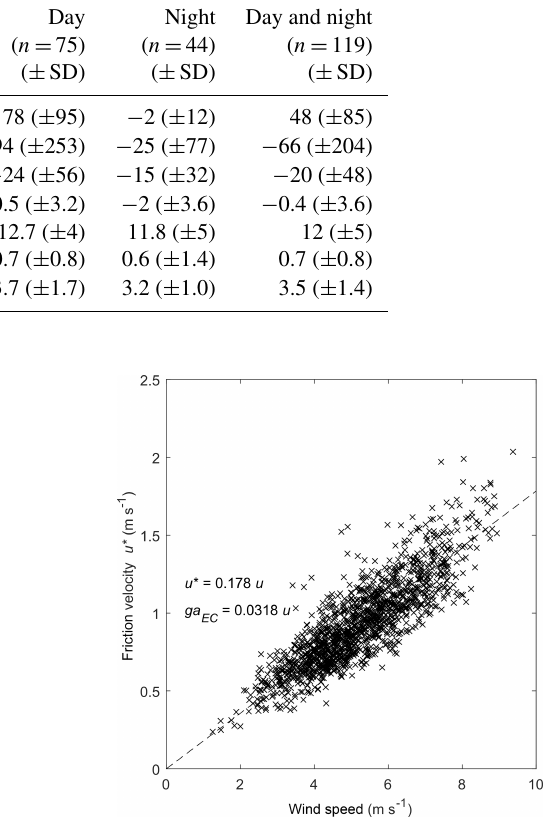
Figure 5. Linear regression of friction velocity u ∗ against wind speed u for near-neutral hours ( − 0.02 <(z − d)/L< 0.02) and from a south-westerly wind